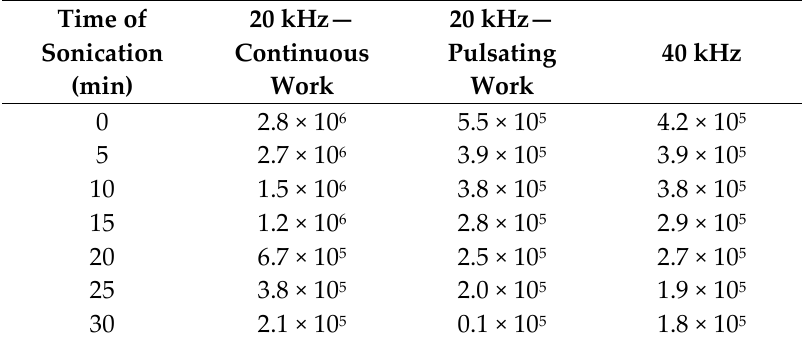
Table 1. Number of microorganisms in mixed sewage sludge treated with ultrasound (own